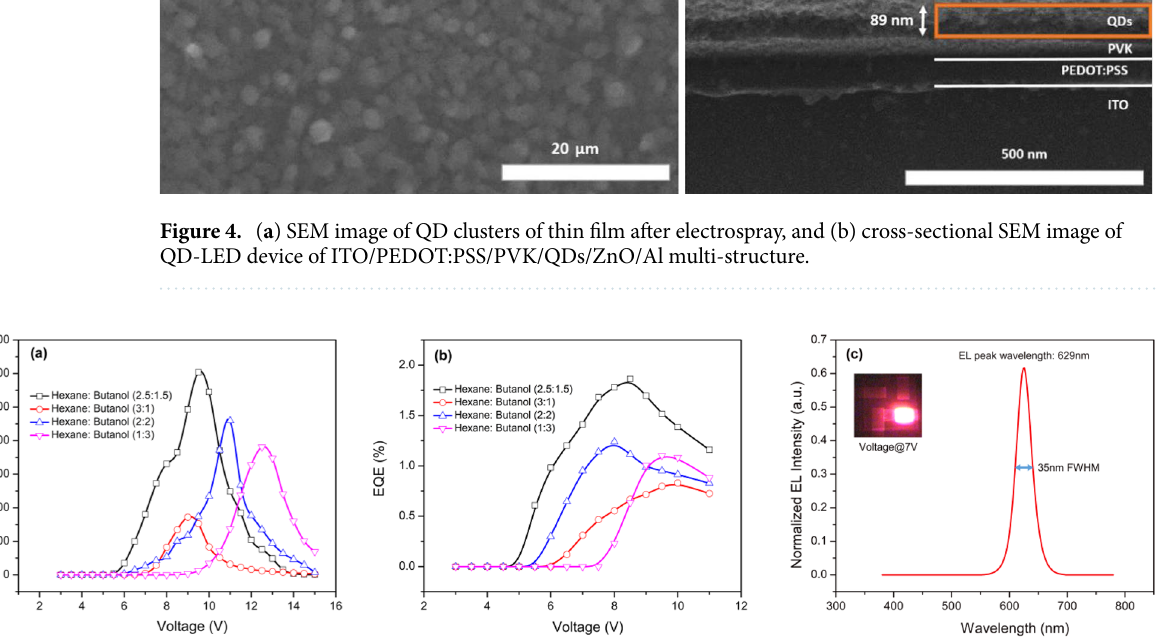
Figure 5. Optical characteristics ( a ) L-V and ( b ) EQE-V of the QD-LED devices using electrosprayed QDs with various solvent mixtures. ( c ) EL spectra and illuminating image of red QD-LED at 7 V (inset